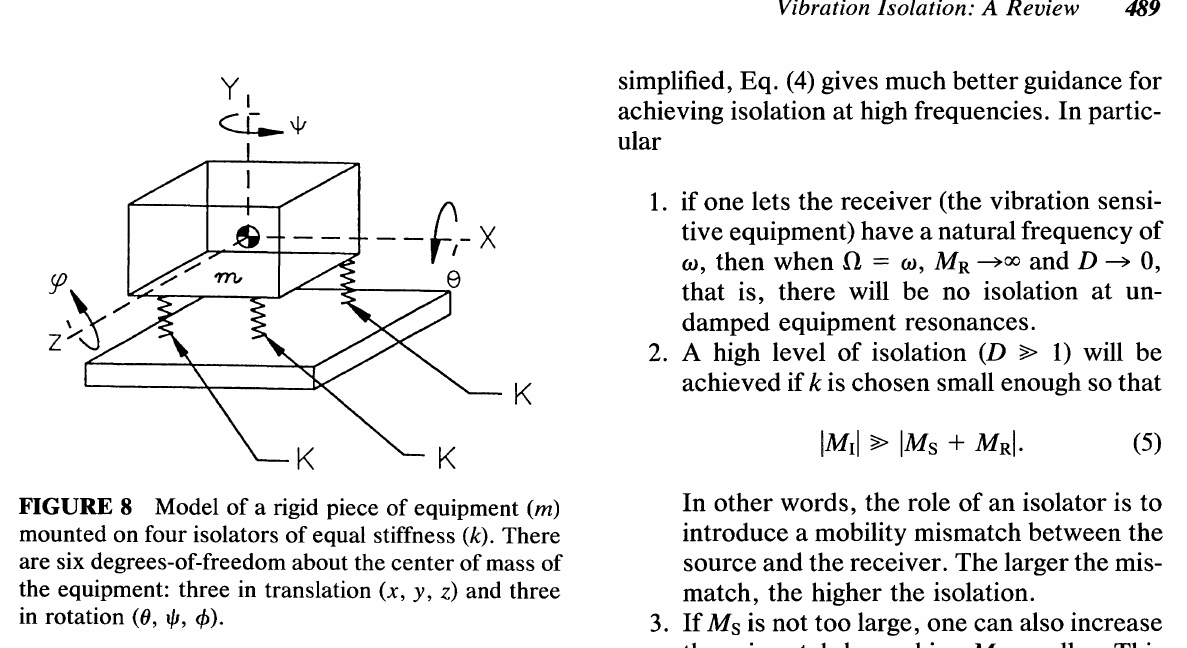
FIGURE 8 Model of a rigid piece of equipment (m) mounted on four isolators of equal stiffness (k). There are six degrees-of-freedom about the center of mass of the equipment: three in translation (x, y, z) and three in rotation (8, $, cp).